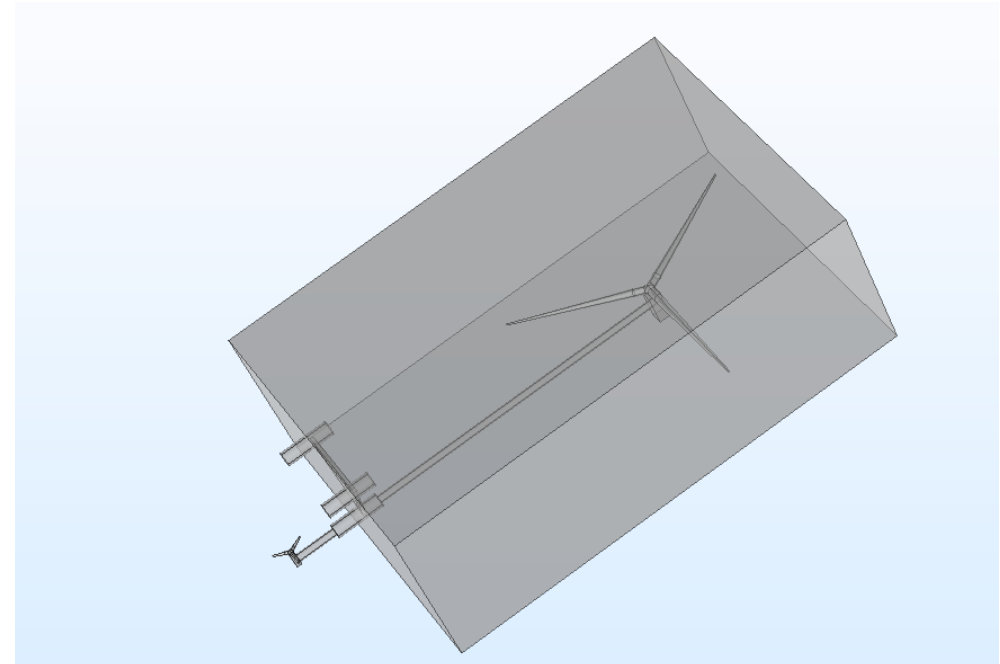
Figure 4. Wind tunnel using the software.